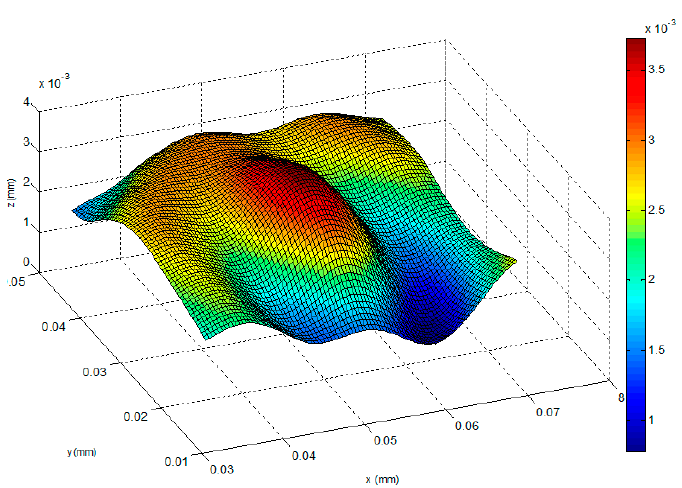
Figure 18. The reconstructed shape of the traditional SFD [6].